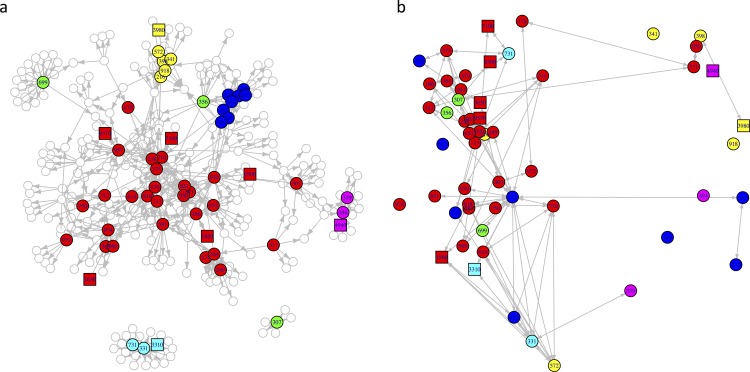
Networks.a) Questionnaire-based network from the SPH faculty and staff and B) network reconstructed from genetic data from oral commensal bacteria. Nodes are colored by campus building locations of offices. Circular nodes represent faculty and staff, and square nodes represent spouses.